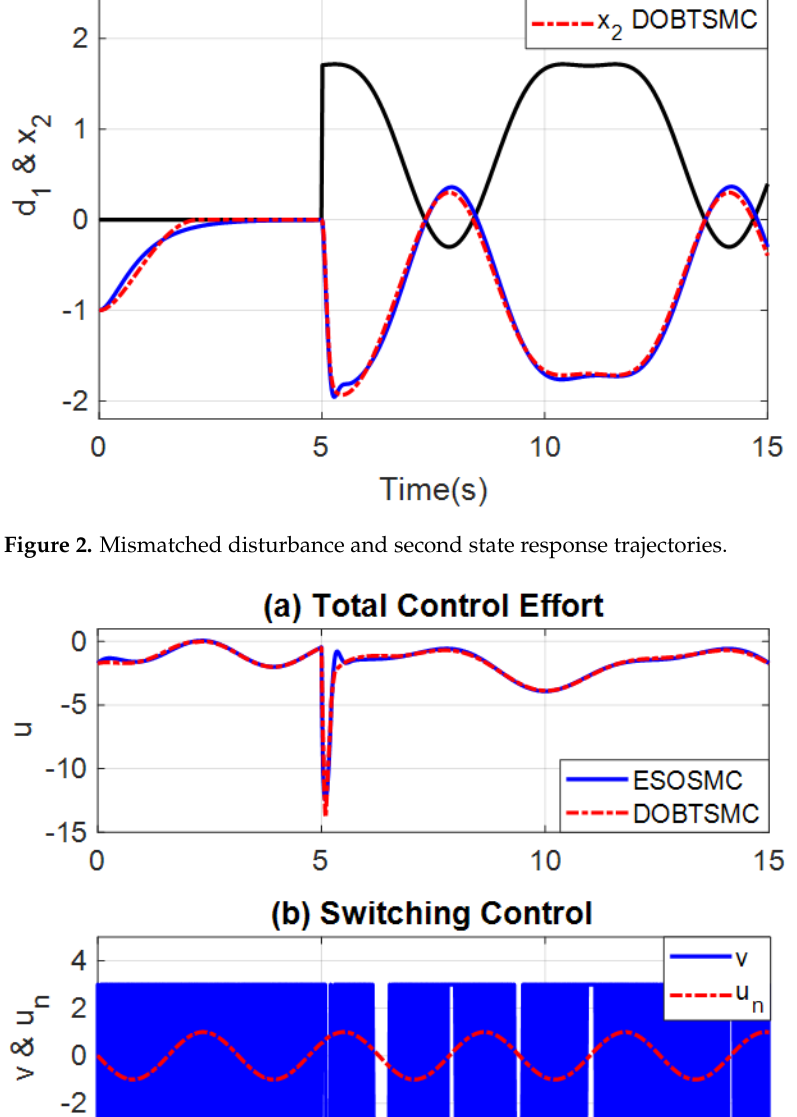
Figure 4. Mismatched disturbance estimation error of ESOSMC and DOBTSMC.